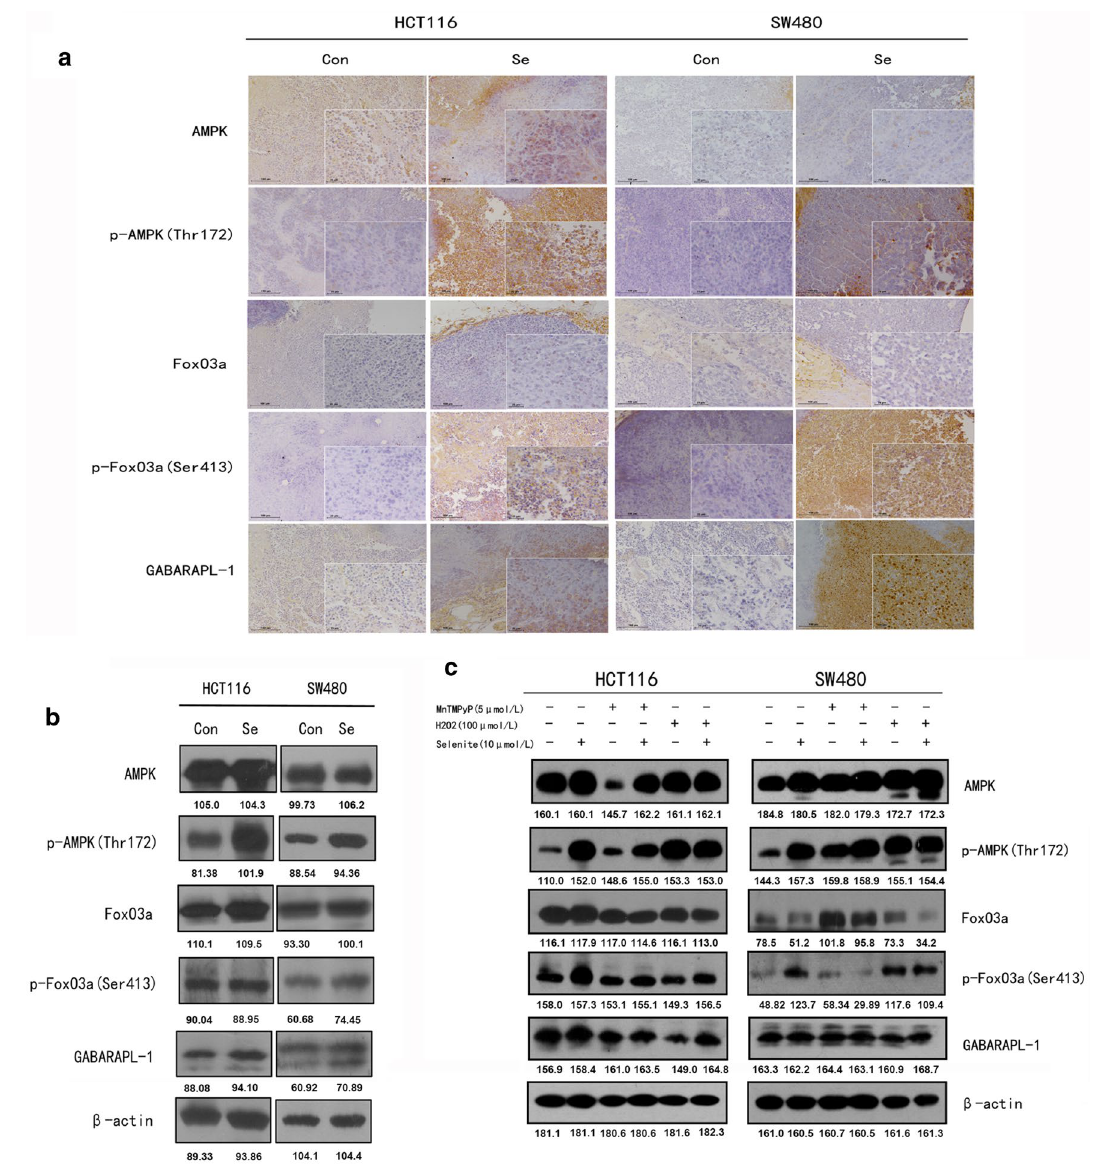
Fig. 4 Selenite activated AMPK/FoxO3a/GABARAPL-1 signaling in colorectal cancer xenograft model. a Immunohistochemistry results of HCT116 and SW480 xenograft model with antibodies for AMPK, p-AMPK, FoxO3a, p- FoxO3a and GABARAPL-1. Scale bar, 100 µm and 25 µm for the larger picture and boxed area, respectively. b Western blot analysis of the tissue sample. c Influence of ROS depletion on AMPK/ FoxO3a/GABARAPL-1 signaling. Cells were pretreated with 5 µM MnTMPyP 2 h before selenite